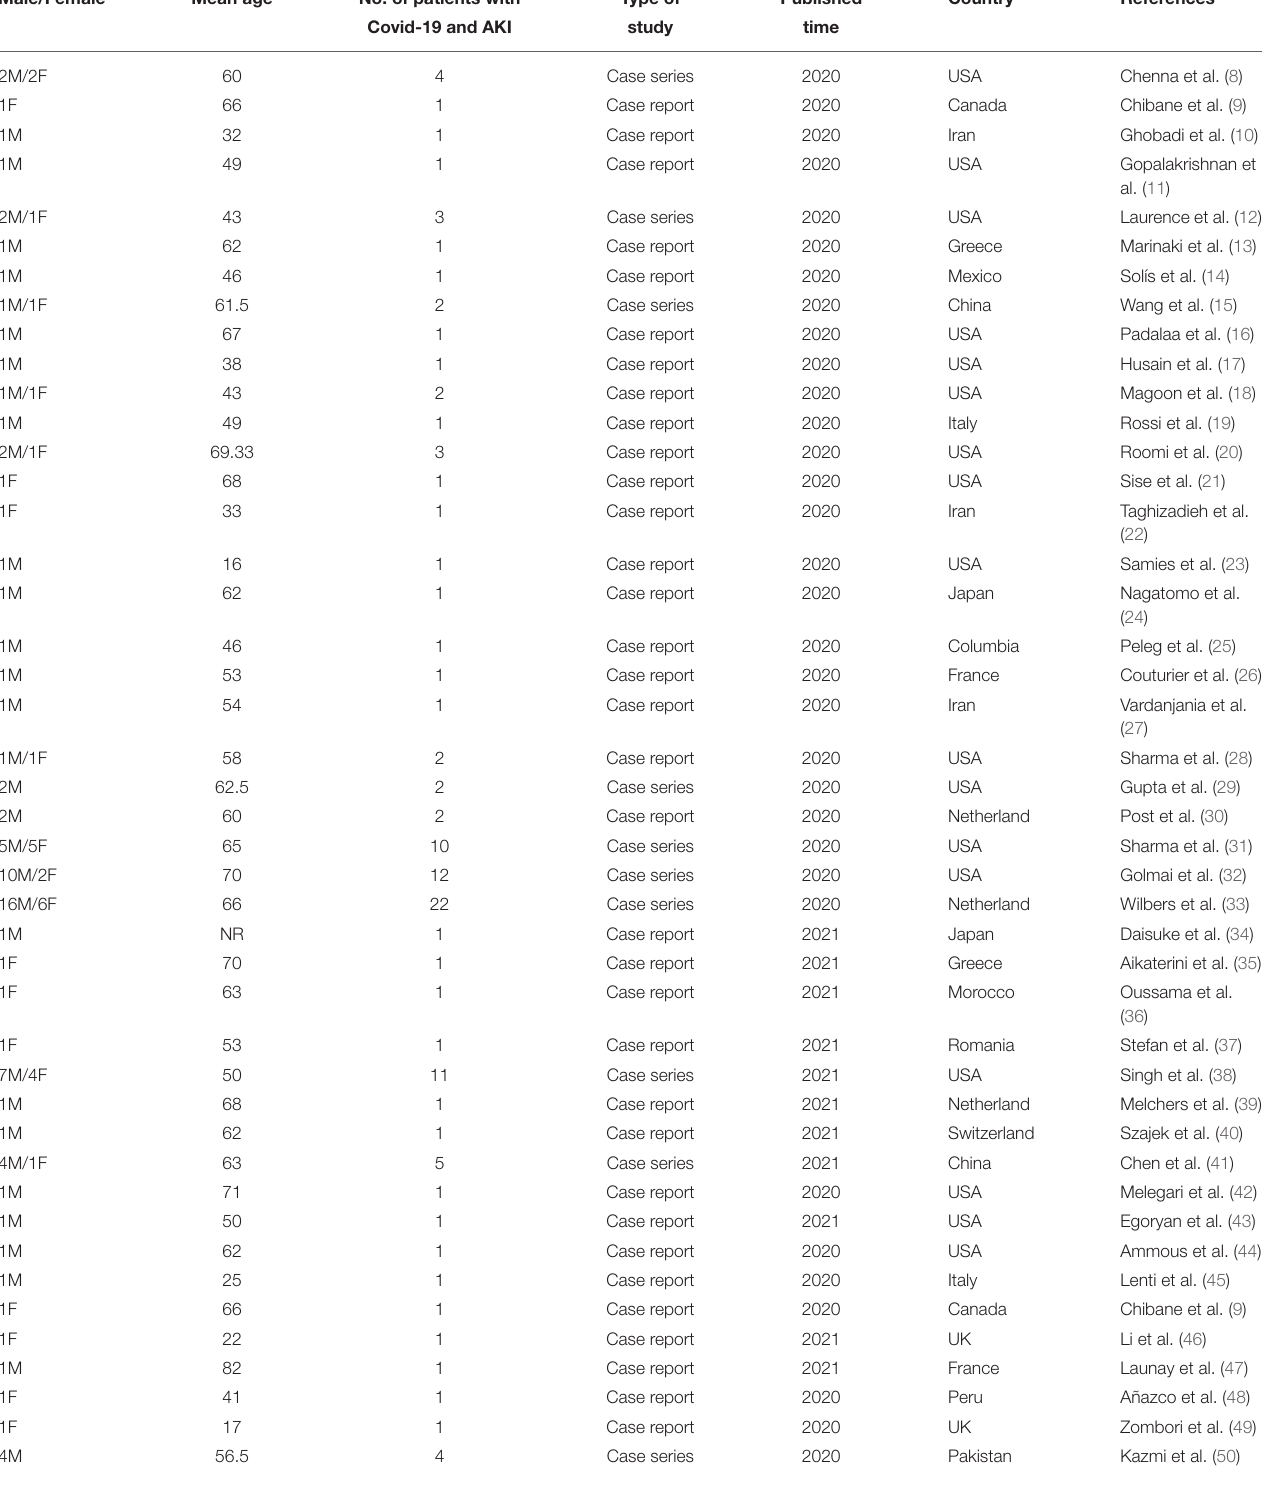
TABLE 1 | Characteristics of Case reports/case series